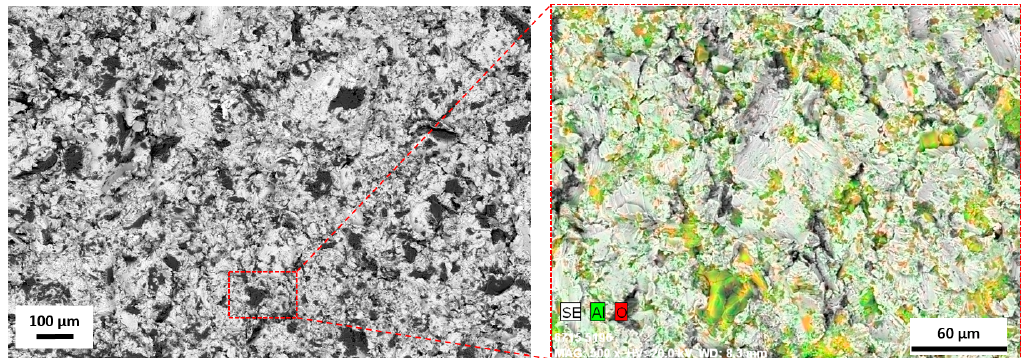
Figure 3. The element distribution map for a sandblasted surface. The colored surface indicates area with Al 2 O 3 particles SEM/EDS.